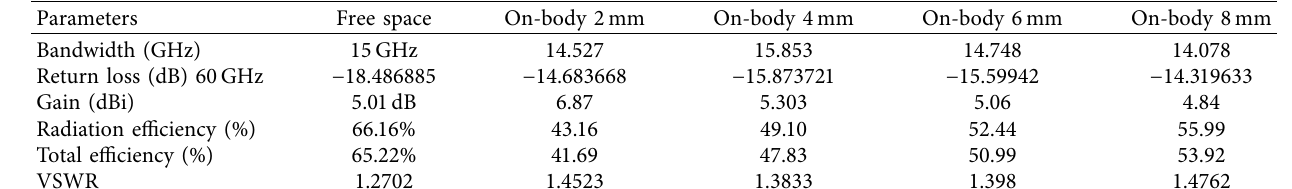
Table 5: On-body comparison of the 1 × 2 array antenna for different distances.